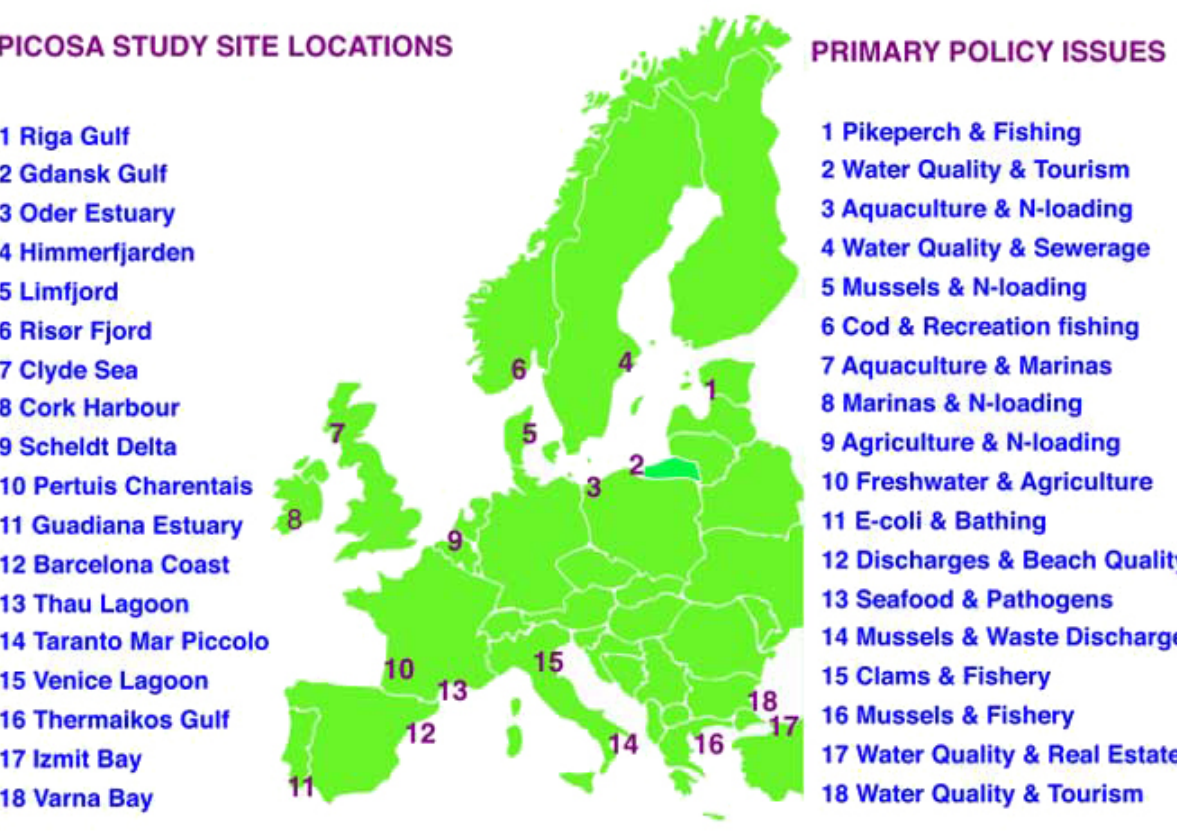
Fig. 1. The 18 study-site locations of the testing and development of the SAF (from SPICOSA 2007). The geographic names are on the left and the corresponding two primary policy issues on the right. N =